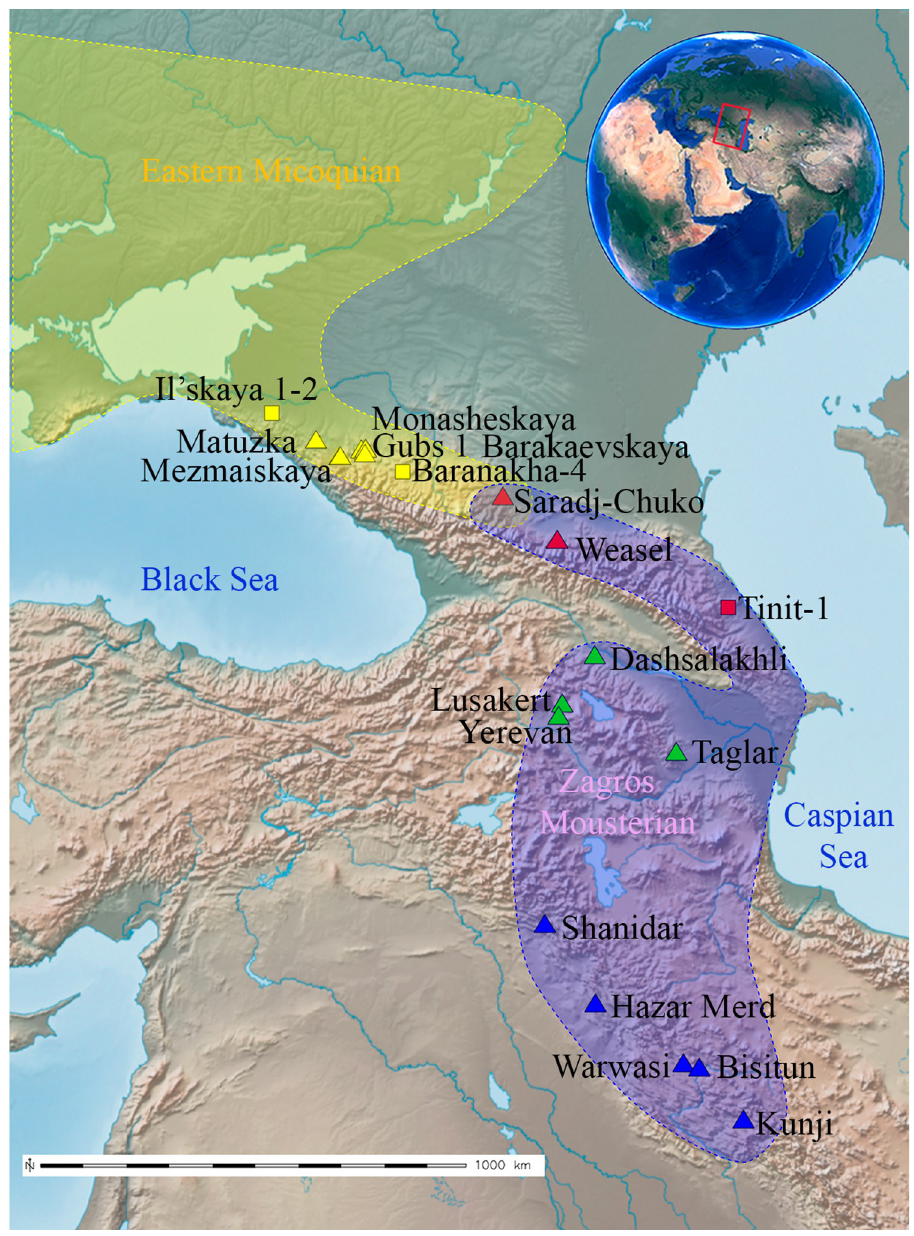
Fig 1. Map showing distribution of the Eastern Micoquian industry in Eastern Europe and the west of North Caucasus and the Zagros Mousterian industry in the Zagros, Caucasus, and Armenian Highlands, including the east of North Caucasus. Squares indicate open-air sites and triangles indicate cave sites. Various colors indicate: yellow–main Eastern Micoquian sites in the west of North Caucasus, red–Zagros Mousterian sites in the east of North Caucasus, green–main Zagros Mousterian sites in the Lesser Caucasus and Armenian Highlands, blue–main Zagros Mousterian sites in the Zagros. Data: Natural Earth (public domain at http://www.naturalearthdata.com). Figure produced using GRASS GIS 7.8 and Inkscape 0.97